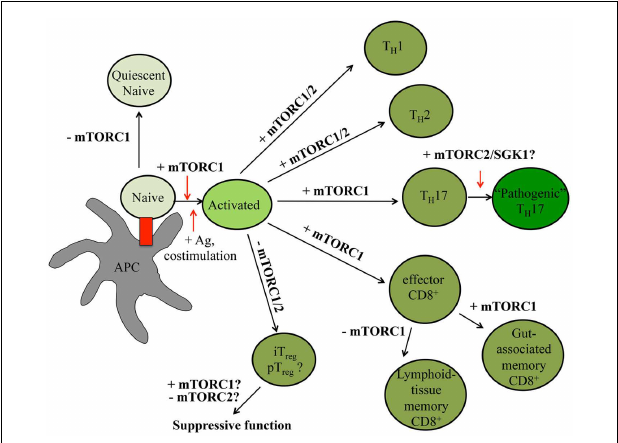
FIGURE 3 | mTOR signaling controls peripheralT cell fate decisions . In the peripheral tissues,T cell quiescence is controlled by low levels of mTORC1 signaling. Upon receiving antigen and co-stimulatory signals, T cells rapidly expand. In the presence of select cytokines, CD4 + T cells further differentiate into different effector CD4 + T cell lineages. CD8 + T cells will become effectorT cells before becoming memoryT cells.The roles mTORC1 and mTORC2 serve in variousT cell states are indicated within the figure, with positive roles shown with plus ( + ) signs and negative roles indicated by minus ( − ) signs. Question marks (?) indicate pathways requiring further